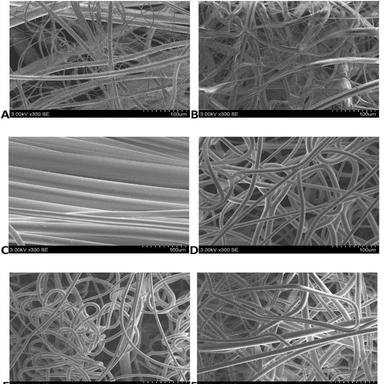
SEM images of typical morphologies (A - disperse (N9D); B - ribbon (N7B); C - parallel (N25E); D - normal (N4A); E − supressed whipping (N8A); F - glued (N3C).